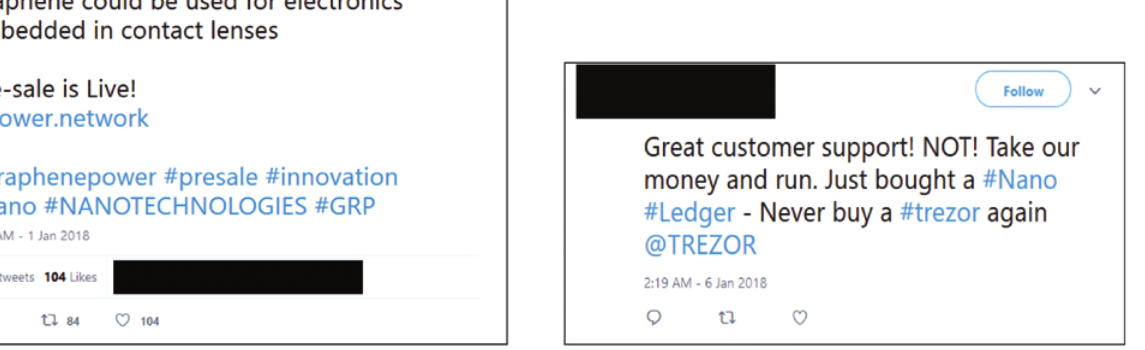
Figure 2: A sample tweet